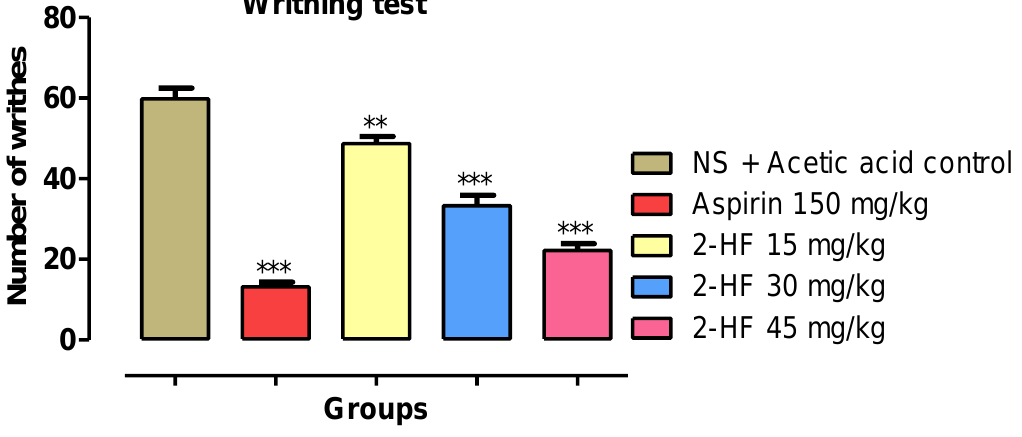
Figure 4. Result of 2HF in writhing test. *** p < 0.001, ** p < 0.01, * p < 0.05 versus disease control.